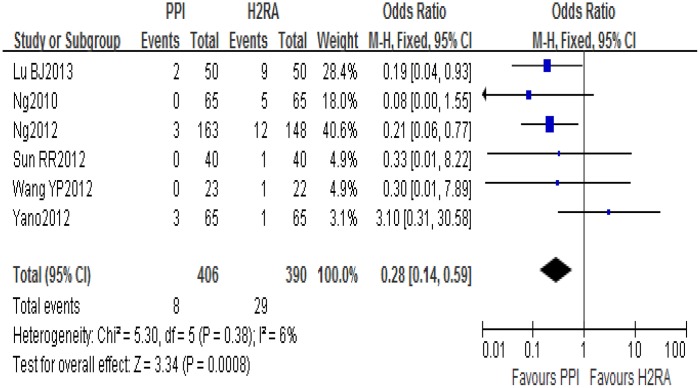
PPIs and H2RAs for prevention of LDA-associated GI bleeding.